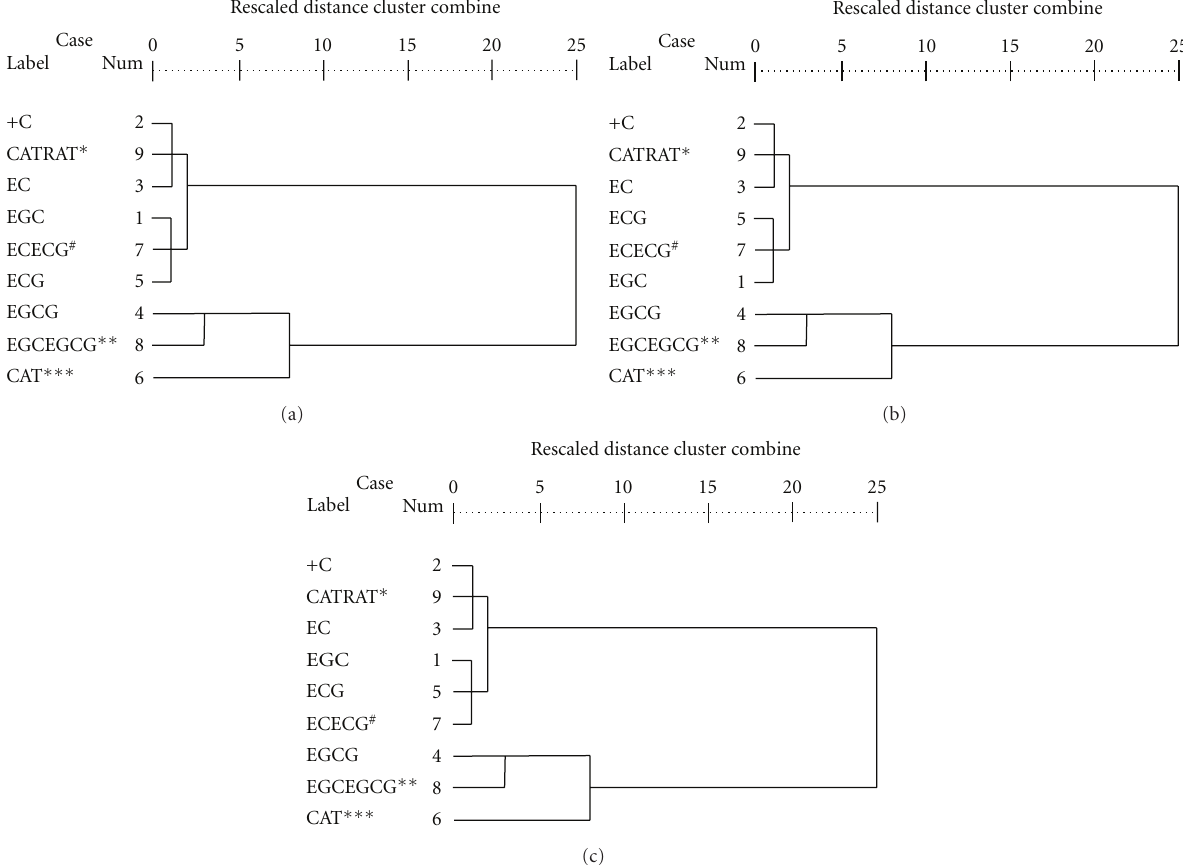
Figure 3: Dendrogram for cluster analysis. The dissimilarity defined by Euclidean distance and the combination of clusters is based on Ward method. (a) Assam, (b) Cambod, and (c) China tea ( ∗ CATRAT: catechin ratio; # ECECG: dihydroxy catechin; ∗∗ EGCEGCG: trihydroxy catechin, and ∗∗∗ CAT: total